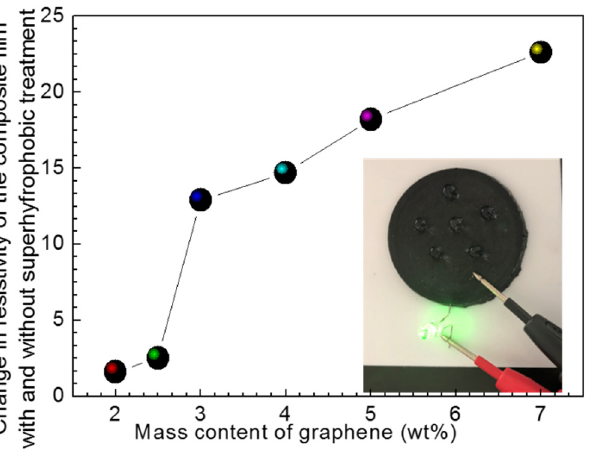
Figure 10. Change in resistivity of the composite films with and without superhydrophobic treatment.